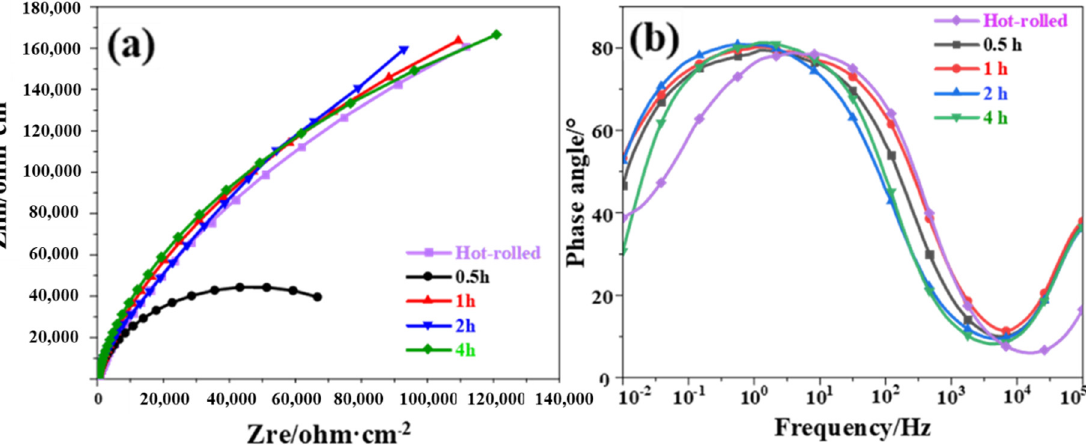
Figure 14. Impedance Spectrum of TA10 alloy: ( a ) Nyquist of TA10 alloy; ( b ) Bode diagram of TA10 alloy.